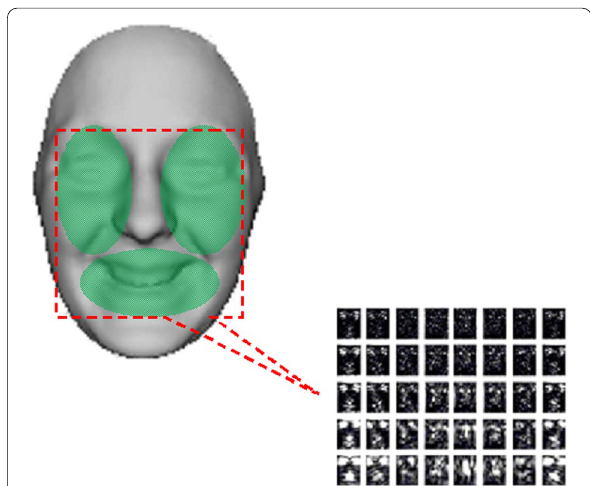
Fig. 5 Gabor magnitude response of the expressive face image: sample image (left), magnitude response image of the whole Gabor filter bank of 40 Gabor filters (right)